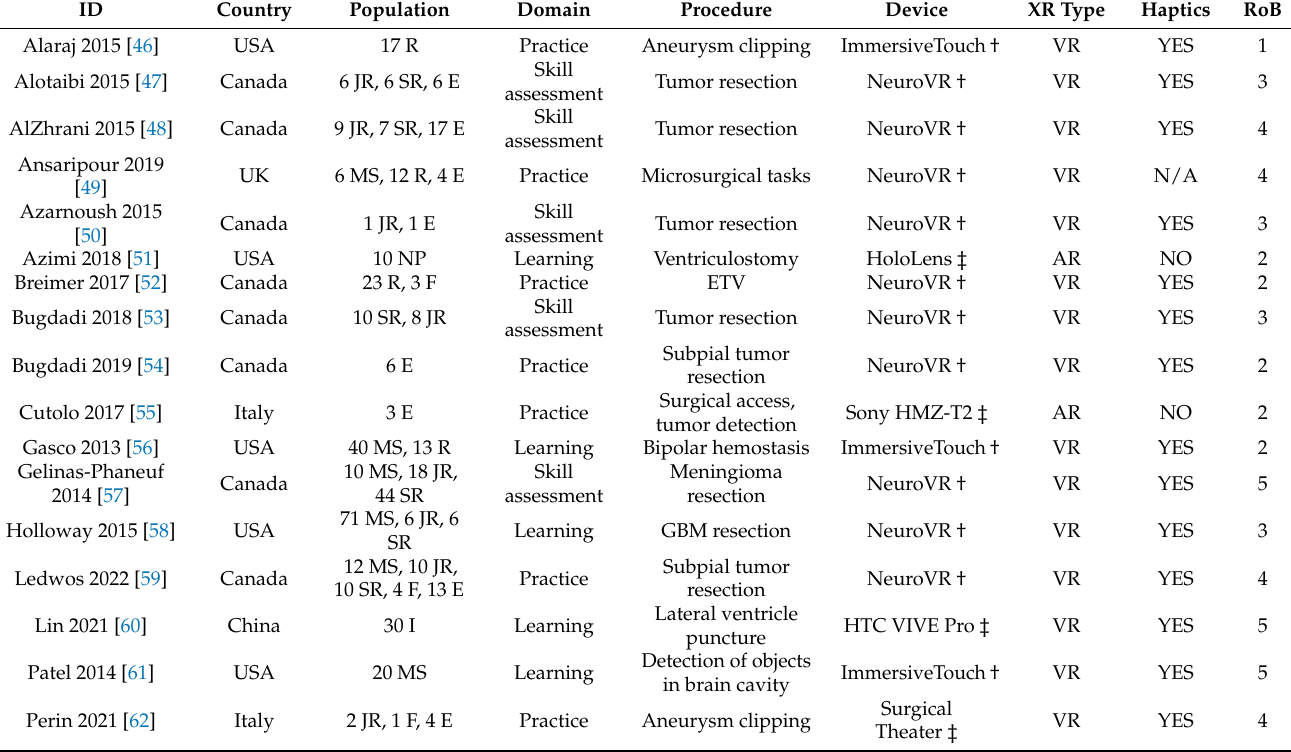
Table 2. Overview of the 31 included studies. Baseline characteristics and data extracted from the